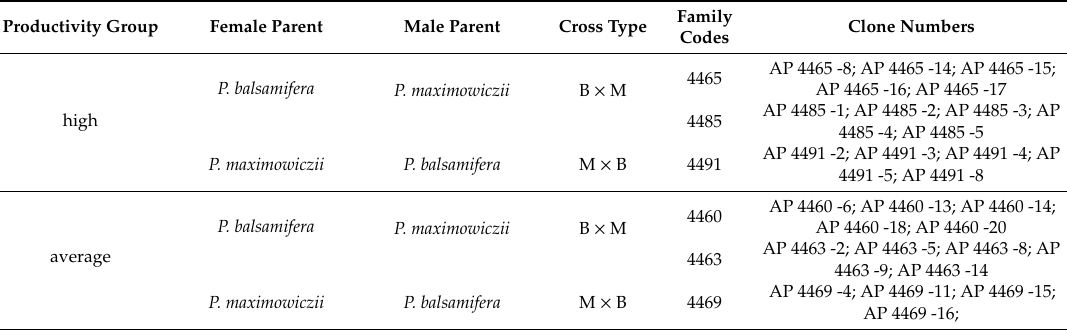
Table 1. Detailed information of 45 selected hybrid poplar clones, including productivity ranking based on volume, female and male parentage, cross type, family codes, and clone numbers, where P. refers to